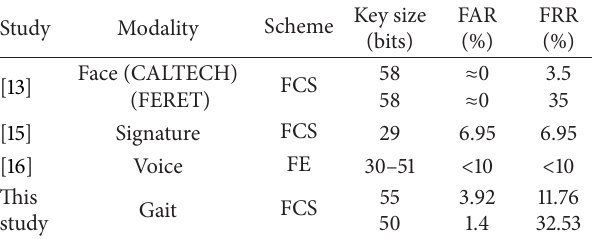
Table 1: Relative comparison of our proposed system and state-of- the-art BCSs using different schemes of fuzzy commitment scheme (FCS) and fuzzy extractor